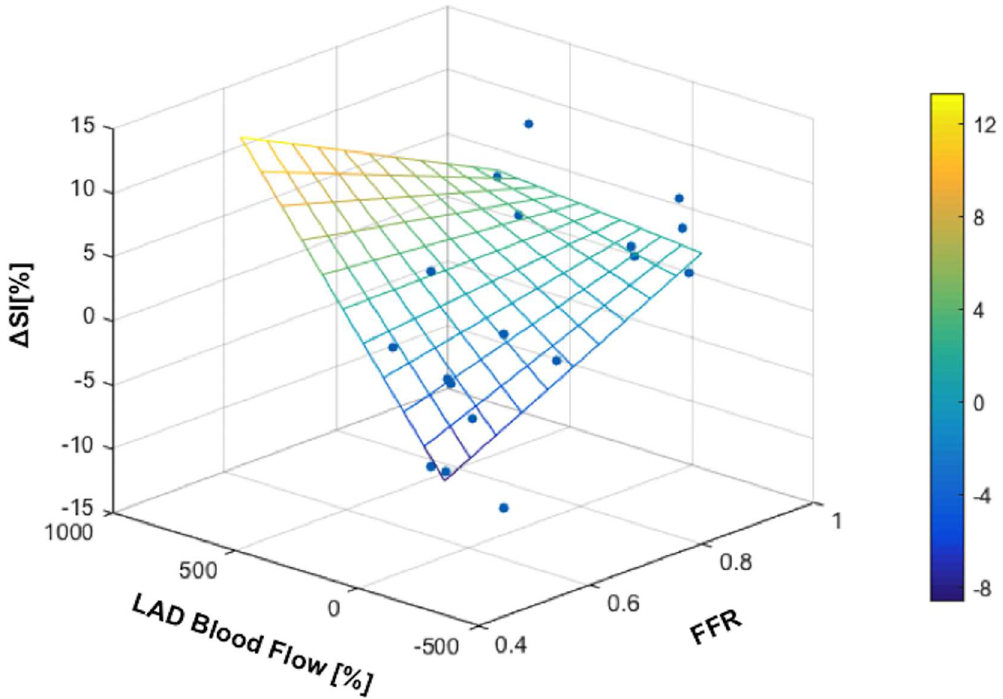
Fig 6. Myocardial oxygenation in relation to coronary blood flow and FFR. SI at the end of the HVBH is linearly related to both the coronary blood flow response (%) and the FFR (Table